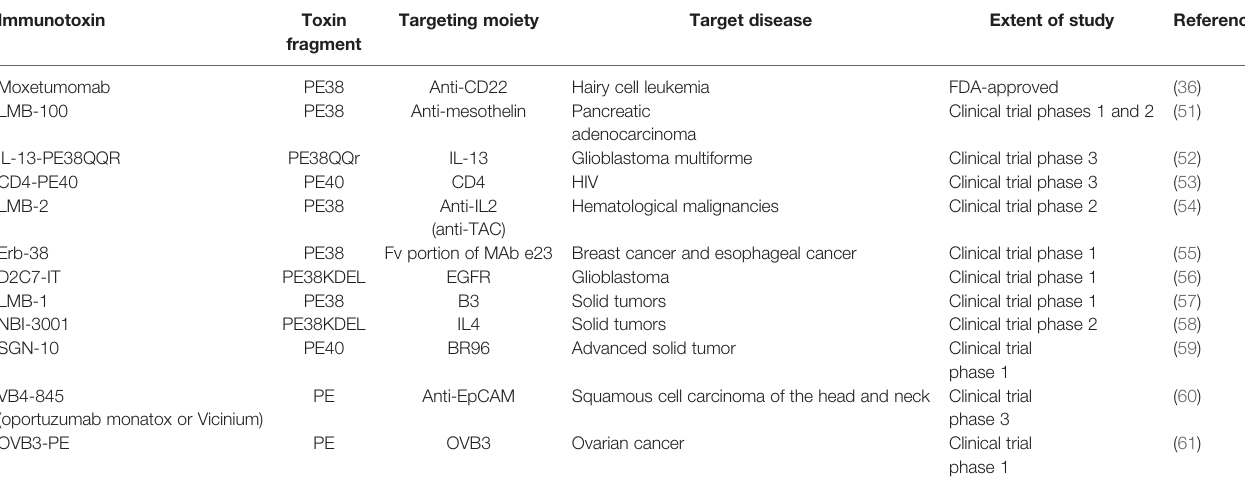
TABLE 2 | PE-derived immunotoxins advanced to various phases of clinical evaluations or clinical application.